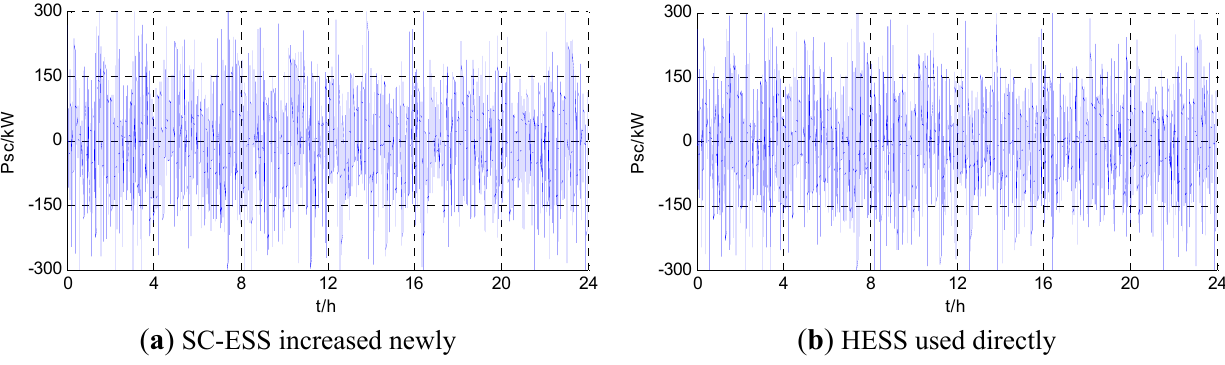
Figure 11. The output power curves of SC-ESS in the latter two schemes.